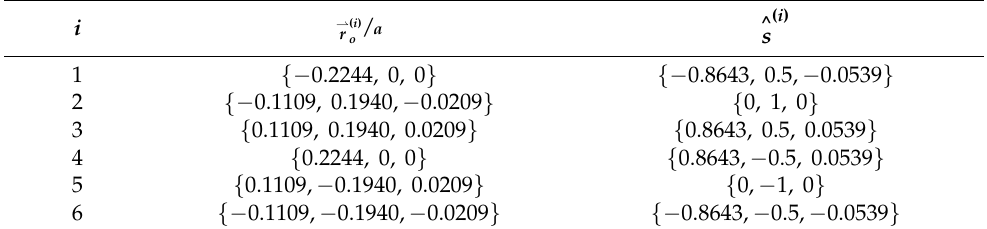
( i ) (cid:42) r Table 1. Position ( o ) of the i -th vertex of the hexagon and direction ˆ s for the i -th scatterer in the case of an achiral hexagon ( φ = 0 in Figure 2) in the coordinate system centered on the hexagon (see Figure 2). Coordinates of vertices are given in units of the unit cell length ( a